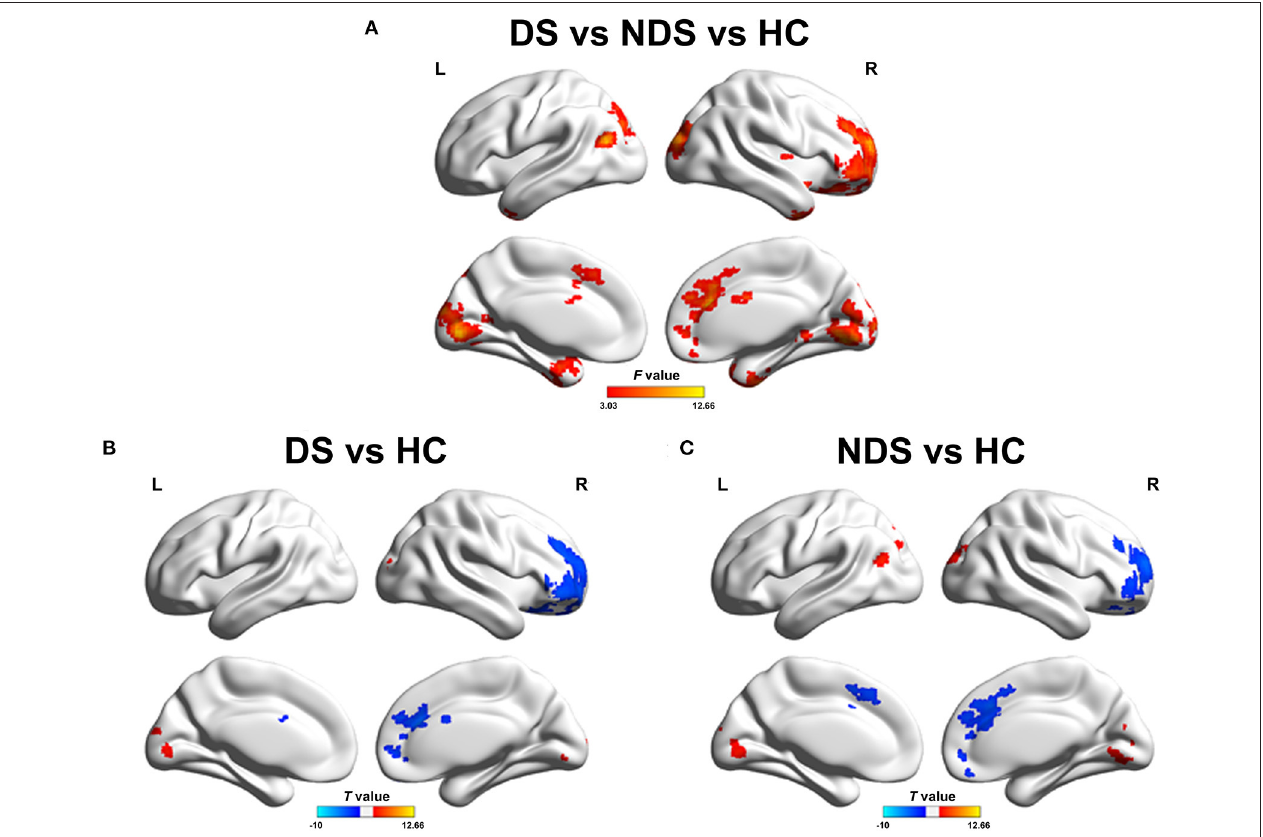
FIGURE 2 | (A) Group comparisons of FC in right NAcc network among DS, NDS, and HC. The red areas denote significant different regions. (B,C) Group analyses of the FC in right NAcc network between patients and HC groups. The blue regions indicate the regions where patients had lower FC compared to HC; the red areas show the regions where patients had greater FC compared to HC. The significant threshold was set at p ≤ 0.05 after 3dClustSim corrected (voxel p ≤ 0.05, cluster size ≥ 200). FC, Functional Connectivity; NAcc, Nucleus accumbens; DS, Deficit Schizophrenia; NDS, Non-Deficit Schizophrenia; HC, Healthy